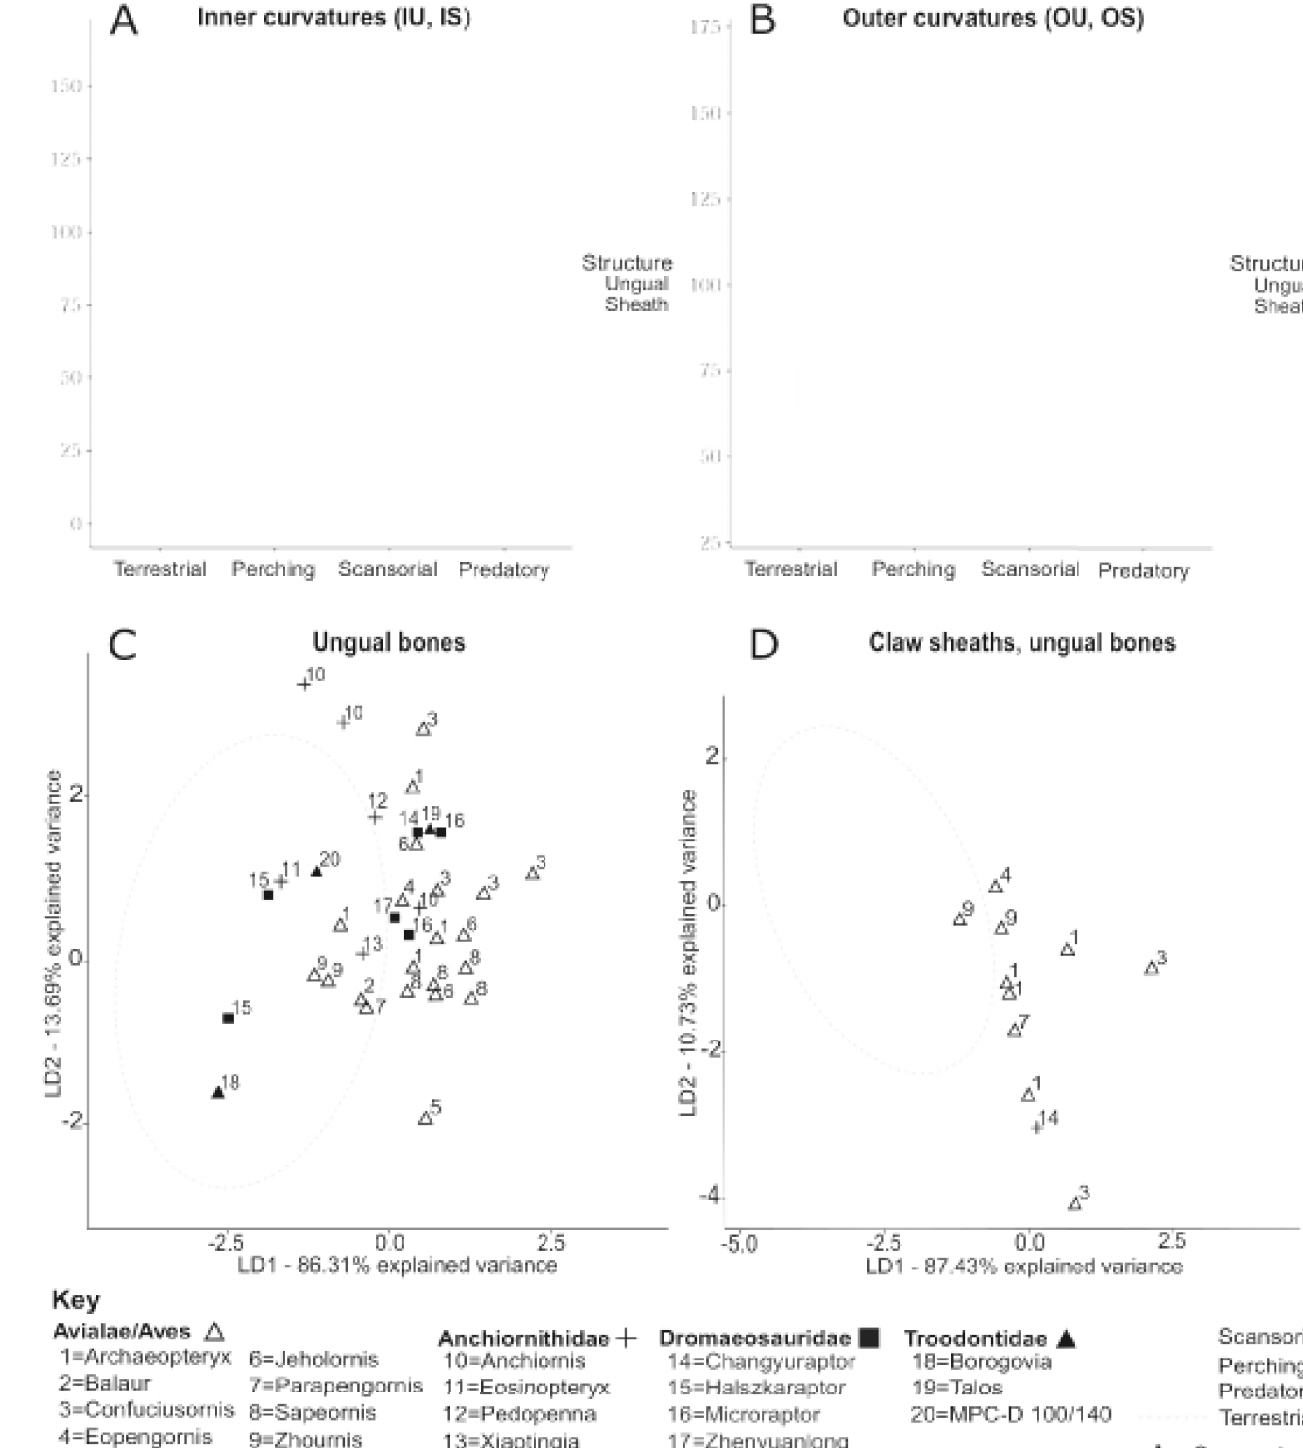
Fig 4. Curvatures of ungual bones and claw sheaths, digit III, for all extant and fossil taxa. Boxplots for inner (A) and outer (B) claw curvatures distinguished by behavioural category for all extant taxa. Shaded boxes depict interquartile range (IQR). Whiskers depict distance between IQR and points up to 1.5 distances from the IQR. Outliers are represented with circles or stars dependent on taxonomic group and are greater than 1.5 distances from the IQR. Morphospaces based on LD1 and